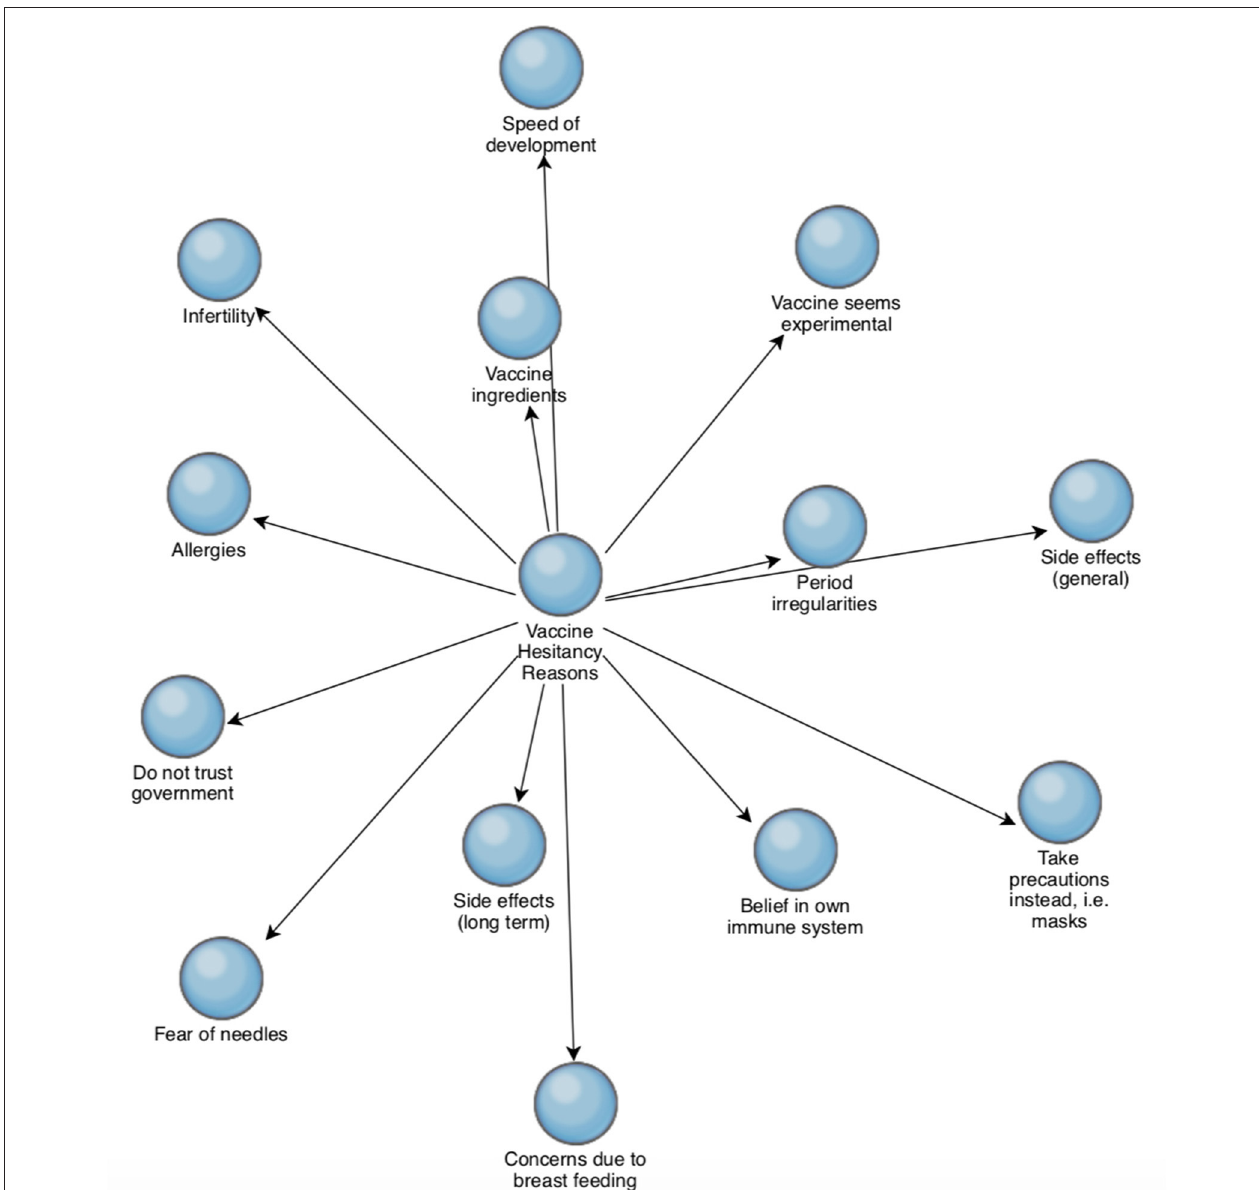
FIGURE 2 | Motivations for having received the COVID-19 vaccine.